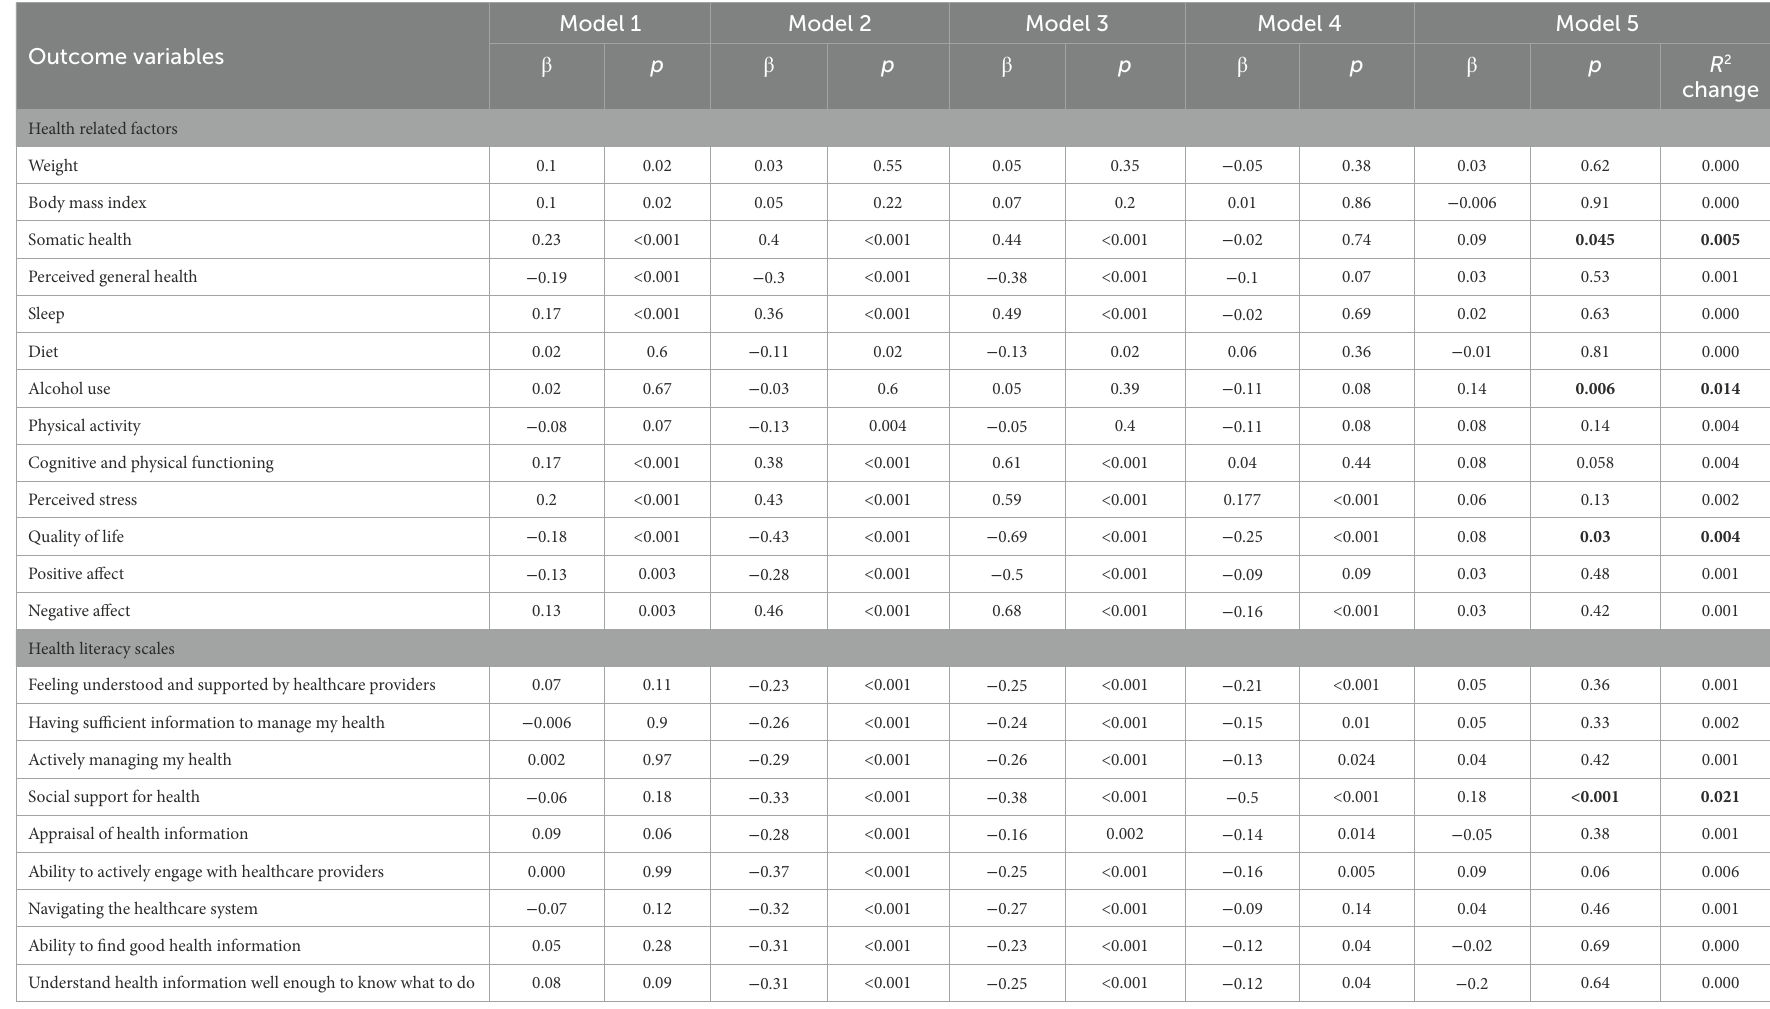
TABLE 5 Hierarchical multiple regression models for how social isolation may differ from loneliness in its impact on health-related factors and health literacy among young adults.